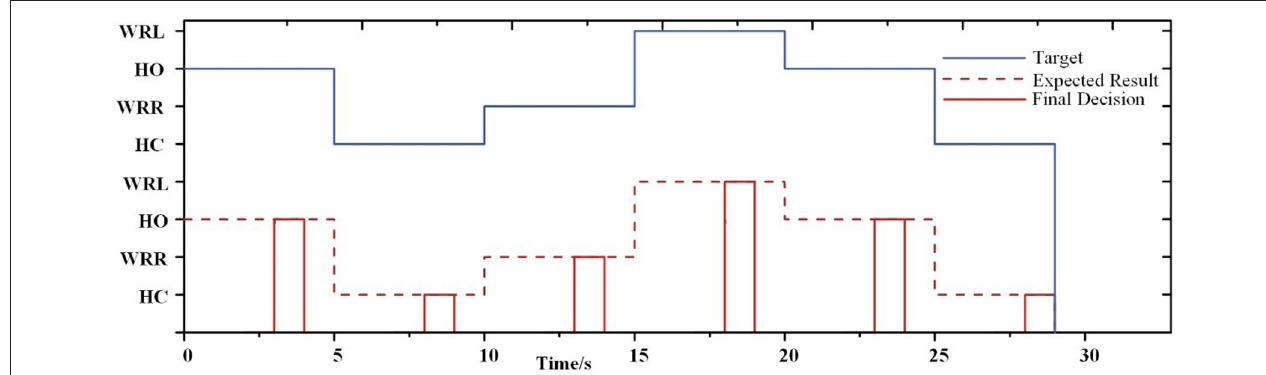
FIGURE 7 | Example of the online experiment for each session in one representative subject (S5).